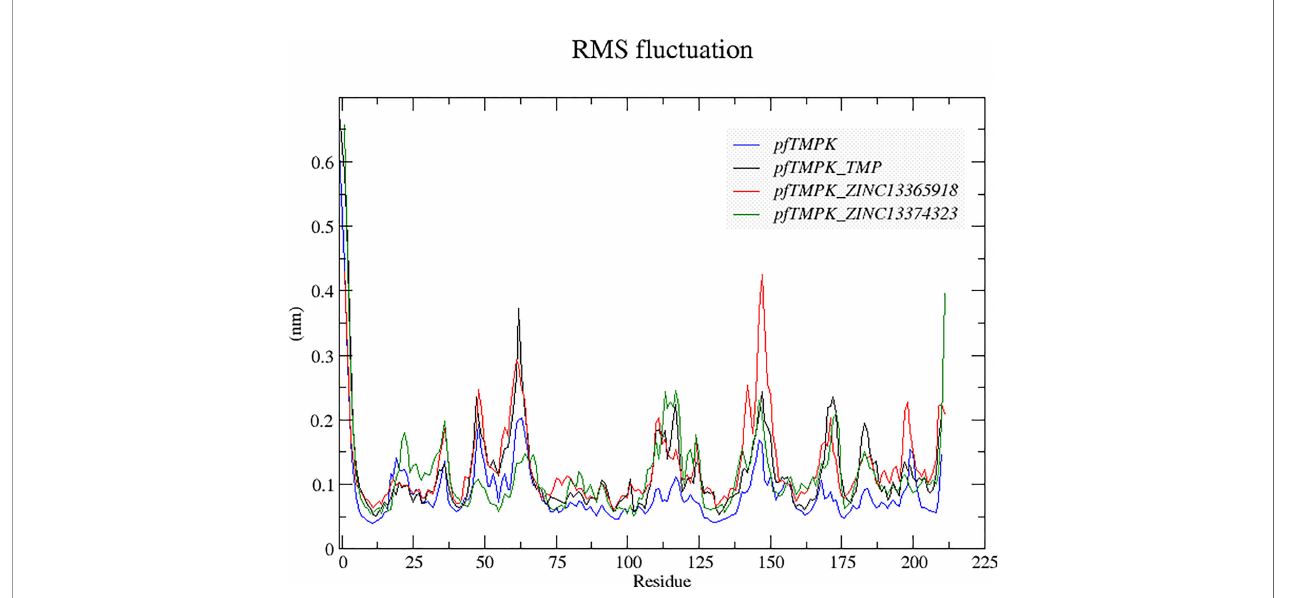
FIGURE 5 | Root mean square fl uctuation (RMSF) graphs comparing the behaviors of the residues of Pf TMPK in complex with its natural substrate (TMP) and the respective compounds with those of the unbound protein. The RMSF graph for the unbound Pf TMPK is shown in blue, for Pf TMPK – TMP black, for Pf TMPK – ZINC13365918 red, and green for Pf TMPK – ZINC13374323.